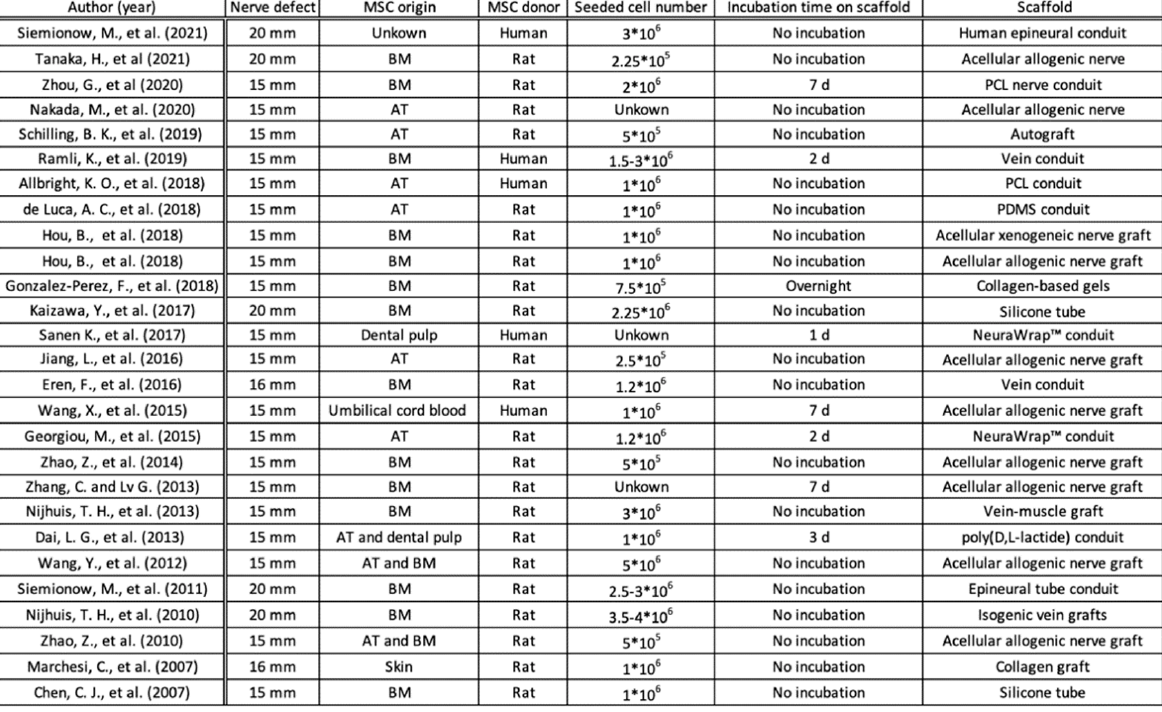
Figure 2. Characteristics of the included studies [5,11–36]. Abbr: AT = adipose tissue, BM = bone marrow, PCL = poly( ε‐ caprolactone), PDMS = poly ‐ dimethylsiloxane.